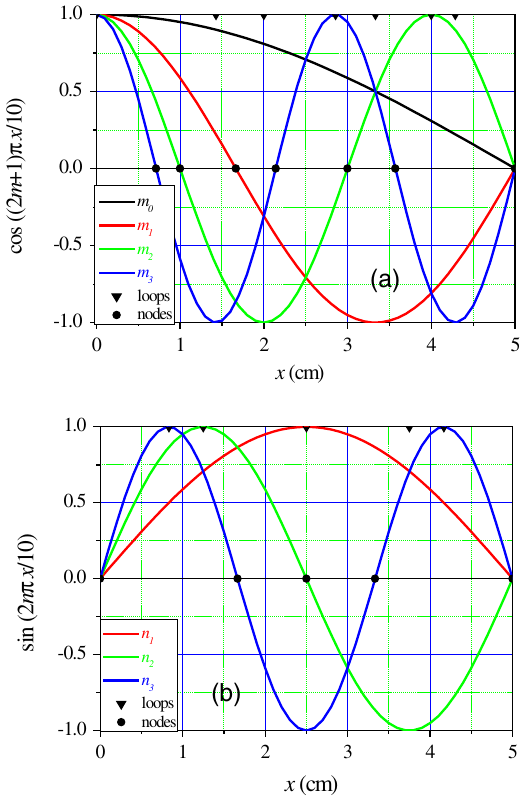
FIG. 3. Photograph of the grating during measurements of the transmission coefficient, showing the antennas connected to the network analyzer. One sidewall is drawn to show its position.